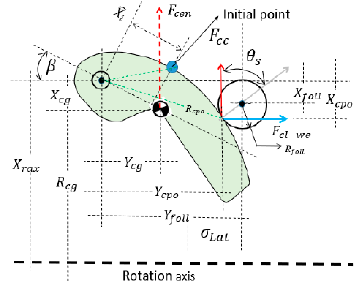
Figure 12. Parameter and variable naming in flyweight cam.